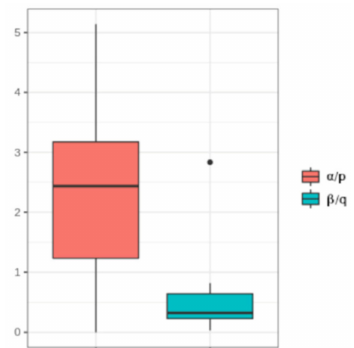
Figure 5. Distribution of the methylation and demethylation ratios. Boxplot of the DNA methylation ratio ( α / p) and of the DNA demethylation ratio ( β / q) in the analyzed